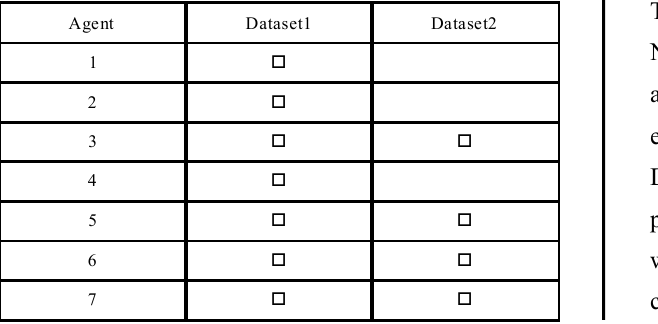
TABLE 2. SELECTED AGENTS FOR DATASET1